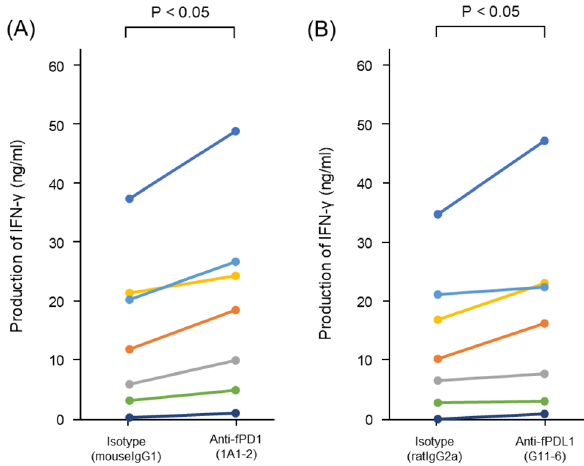
Figure 5. Augmentation of IFN-γ production in concanavalin A (Con A)-stimulated peripheral blood lymphocytes (PBLs) treatment with anti-PD-1 mAb or anti-PD-L1 mAb. PBLs were isolated from seven healthy cats and stimulated with 10 µg/mL of Con A for 48 h in the presence of mouse IgG 1 isotype control or anti-fPD1 (1A1-2) mAb ( A ), rat IgG 2a isotype control or anti-fPDL1 (G11-6) mAb ( B ). After 48 h, the culture supernatant was collected and the amount of feline IFN-γ in the supernatants was measured in duplicate. Different color bars indicate different